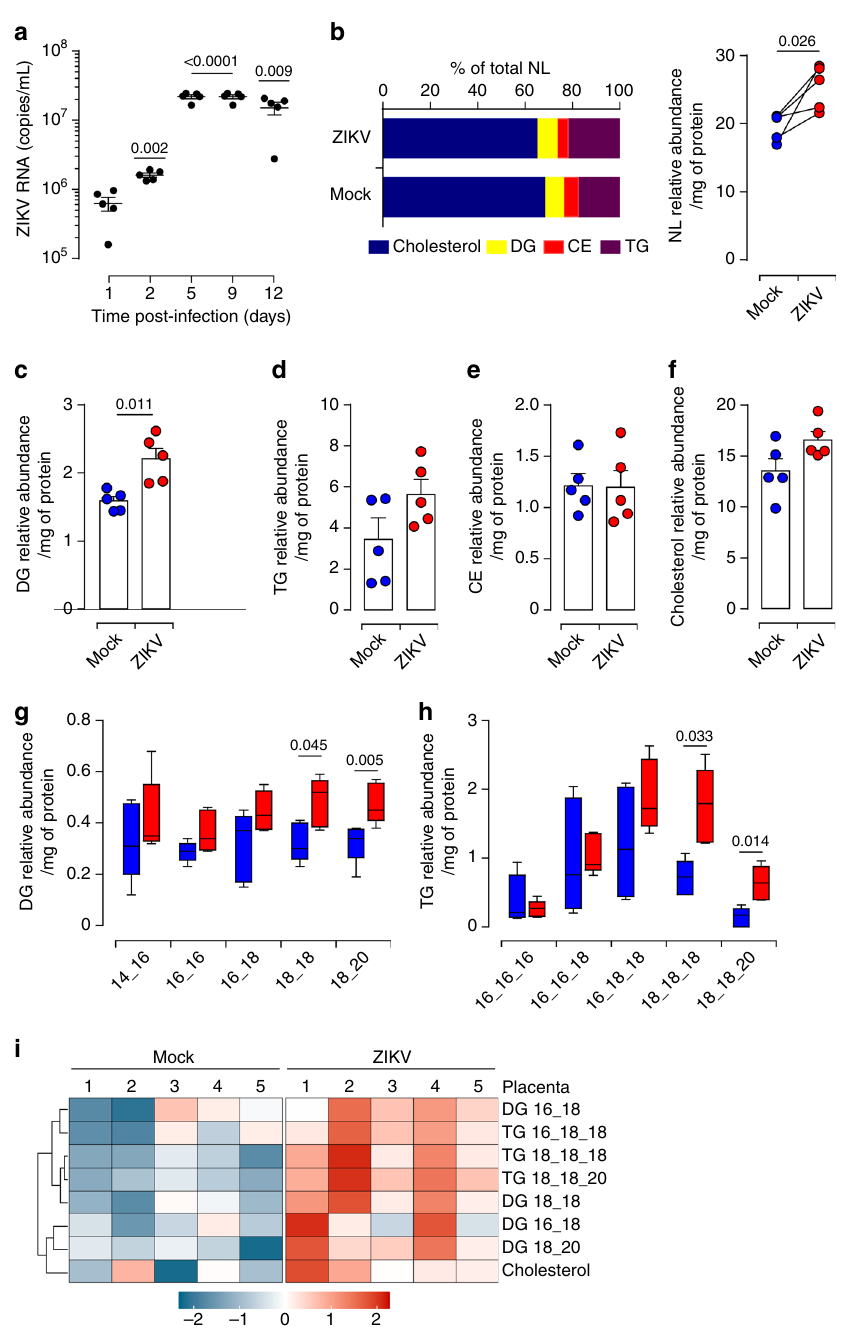
Fig. 1 ZIKV infection impairs placental neutral lipid metabolism. a Culture supernatants are collected from fi ve independent ZIKV-infected fi rst trimester placentas following the indicated time. Viral load is determined by qRT-PCR. b Neutral lipids (NL) are extracted from matched mock- and ZIKV-infected fi rst trimester placentas 5 days post-infection (dpi). Four major neutral lipids, cholesterol, diacylglycerol (DG), cholesteryl ester (CE) and triglyceride (TG), were determined in human placenta. Quanti fi cation of neutral lipid species was achieved by comparison of the peak area of individual species relative to their class-speci fi c internal standards. Values are normalized based on the protein level for each sample. Relative abundance of NL is calculated as the sum of DG, TG, CE, and Cholesterol amounts. c – f Quanti fi cation of DG, TG, CE, and cholesterol. Relative abundance of DG, TG, and CE represents the total abundance of the different subspecies in each group. g – h Quanti fi cation of DG and TG subspecies characterized by the number of carbon atoms in each acyl chain. Mock samples are depicted as blue bars and ZIKV-infected samples as red bars in the graph. Boxplot: boxplot medians (center lines), interquartile ranges (box ranges), whisker ranges. i Heatmap representing relative abundance pro fi le of NL subspecies. Each column represents a single donor and each row corresponds to a single sub-specie of neutral lipids. All the data sets are presented as mean values ± SEM of fi rst trimester placentas from fi ve independent donors. P values are computed using paired two-tailed Student ’ s t test. Source data are provided as a Source Data fi